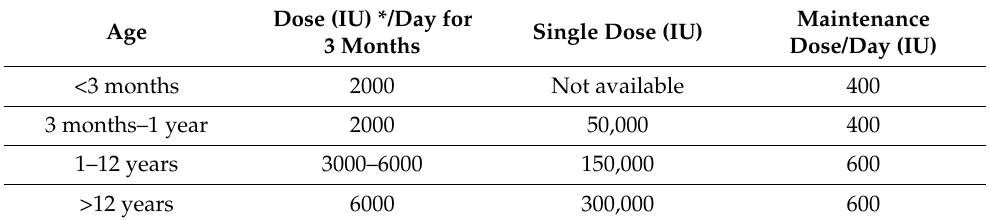
Table 4. Oral doses of vitamin D for treatment of nutritional rickets.